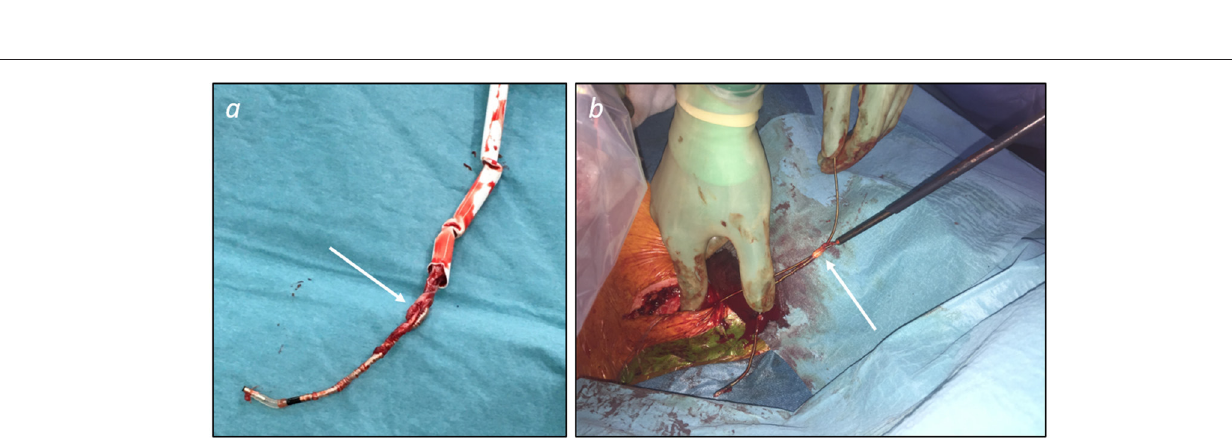
FIGURE 3 | Examples of transvenous leads extracted using mechanical sheaths. (a) Ventricular pacing lead (passive fixation) extracted using a manual non-powered sheath (Philips SightRail TM 11.5F). Tissue adhesions (arrow) at the tricuspid valve level were dissected advancing the sheath while applying a pushing rotational force that explains kicking of the shaft. (b) Active fixation pacing leads extracted while advancing a rotational mechanical sheath (Philips TightRail TM 9F) mounted on the atrial lead. Once the retroclavicular adhesions were overcome, the atrial lead was easily extracted and dragged out together with the ventricular lead because of fibrous tissue (arrow) bounding the leads together at the brachiocephalic vein level.